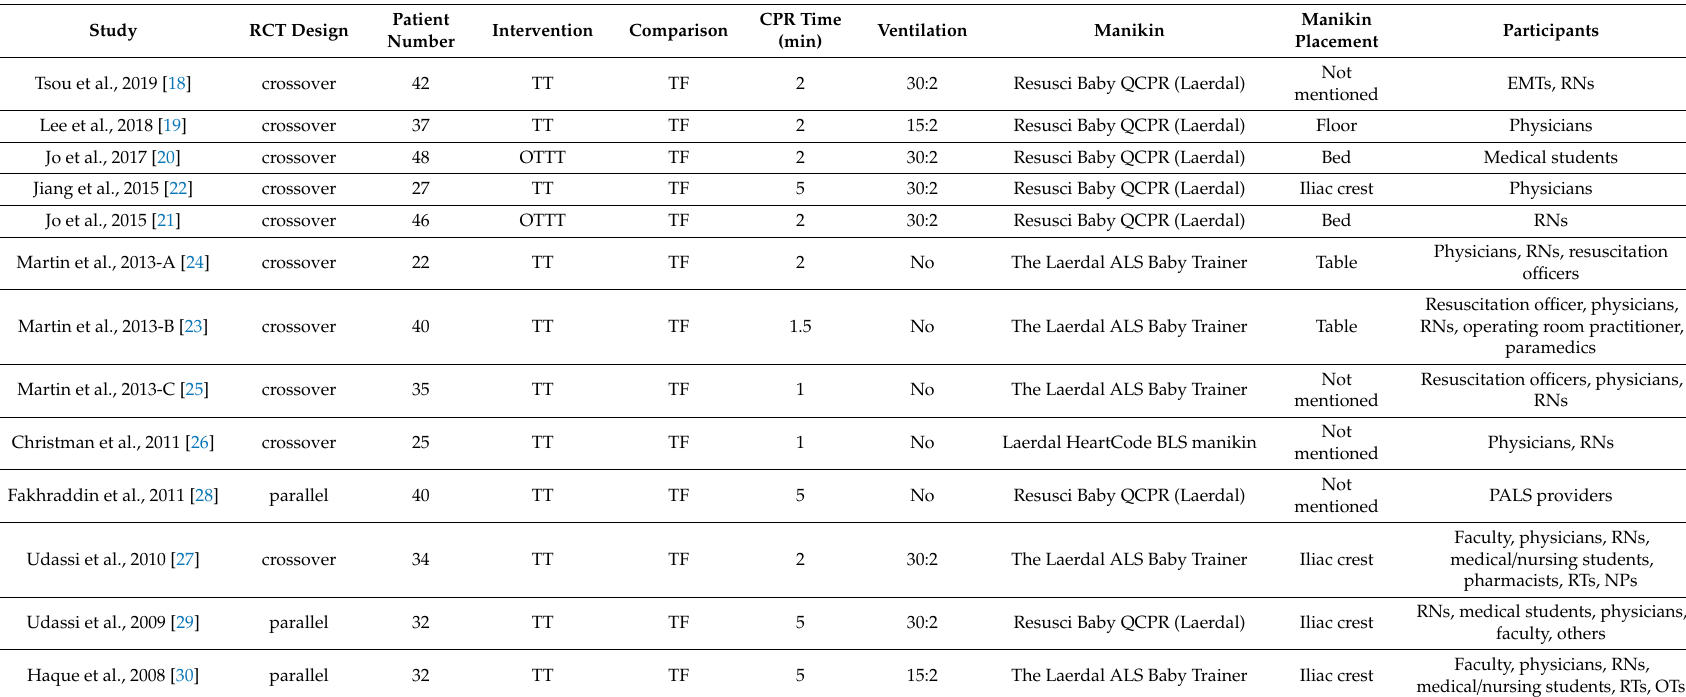
Table 1. The detailed characteristics of the included